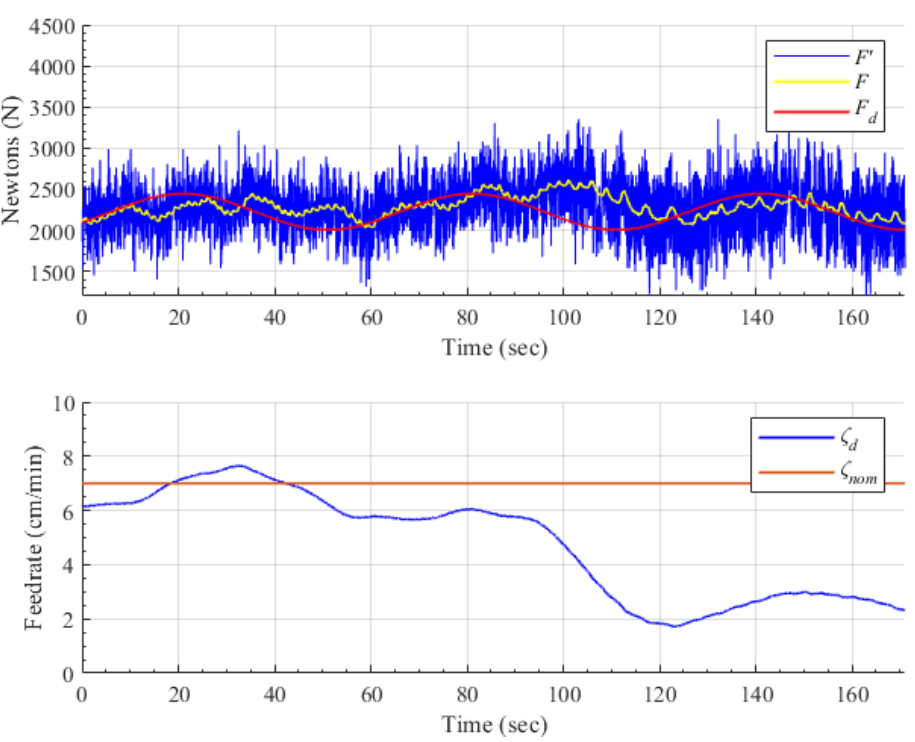
Figure 10. Protocol C. ( Top ) The desired versus measured force. A maximum error of 565.8 N in the filtered force data occurs at t ≈ 105 s. ( Bottom ) The desired and nominal feedrates.